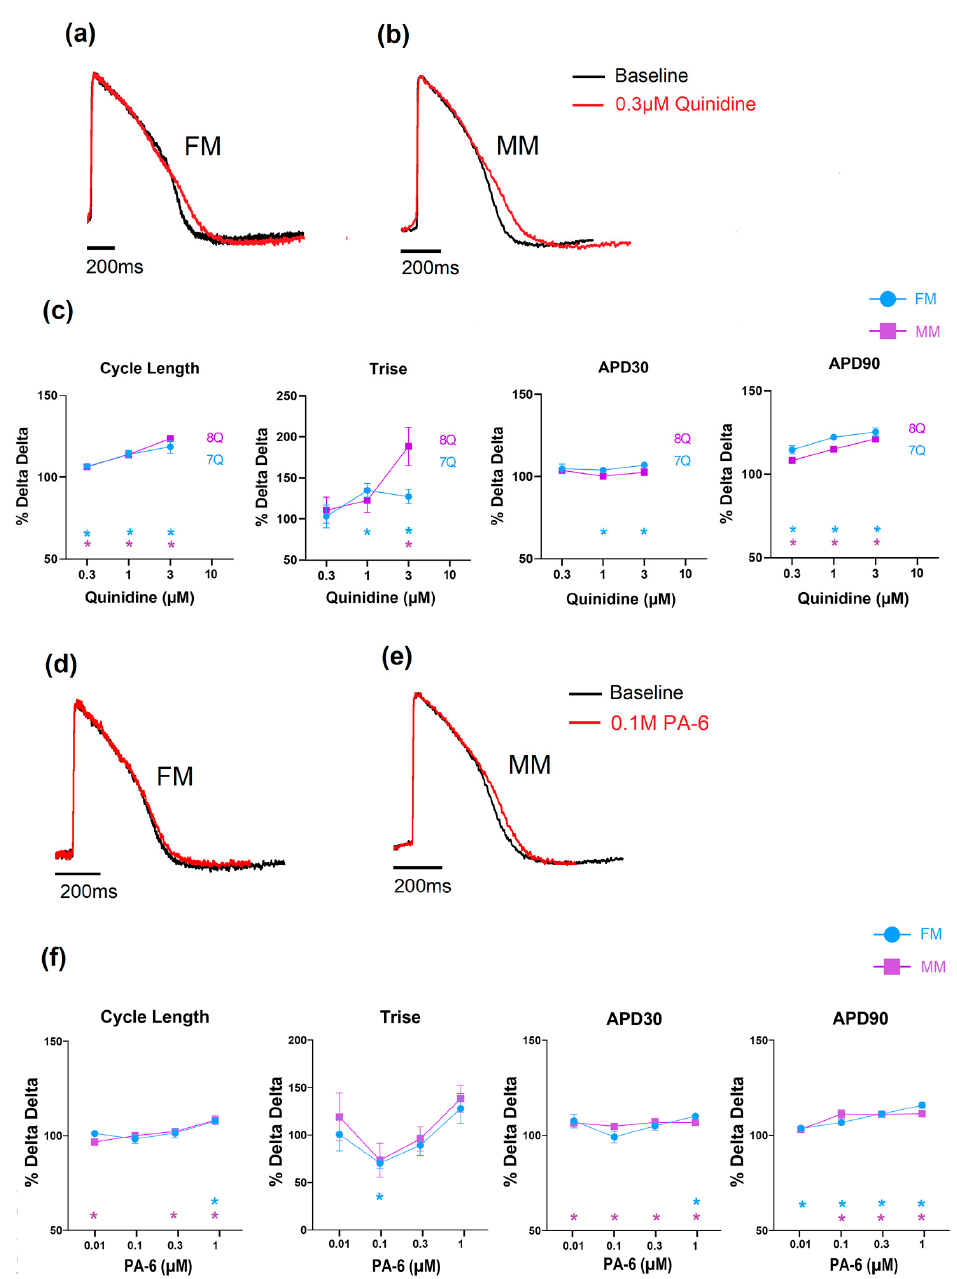
Figure 4. The effect of quinidine and PA-6 on electrophysiology and contractility in the monolayer seeded on fibronectin (FM) and Matrix Plus (MM); ( a – c ): effects of quinidine; ( d – f ): effects of PA-6. (* p < 0.05).